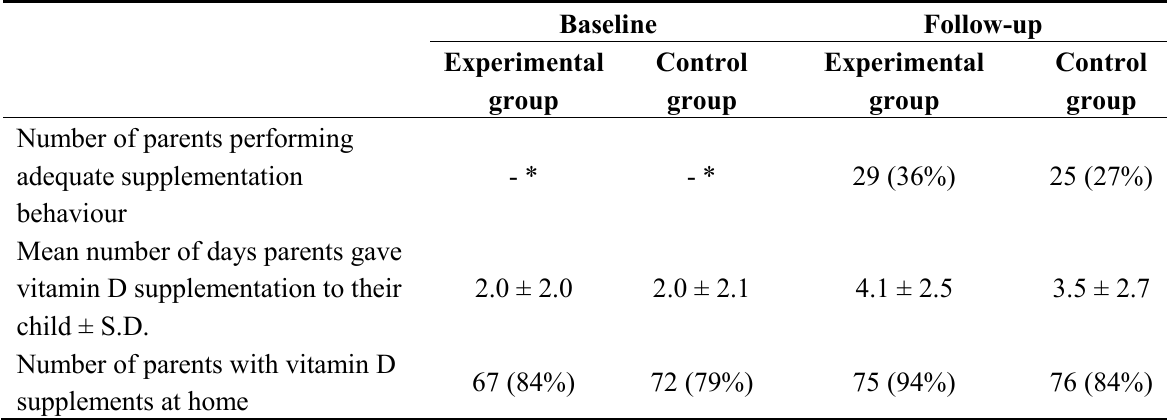
Table 2. Outcome measures in experimental ( n = 80) and control ( n = 91) groups at baseline and